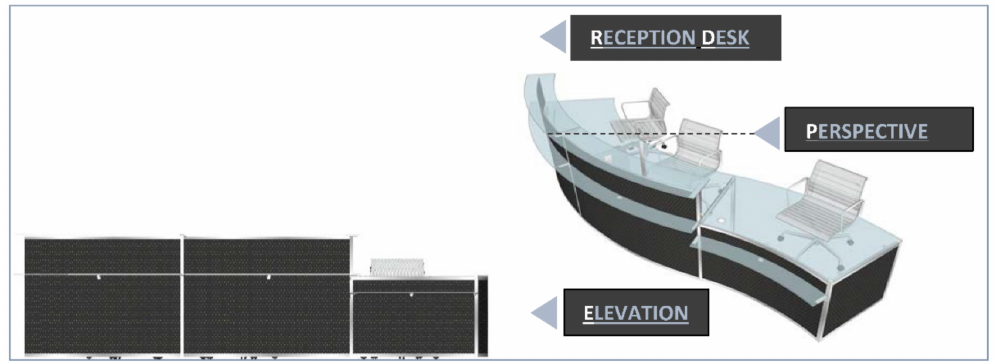
Figure 11. Reception desk